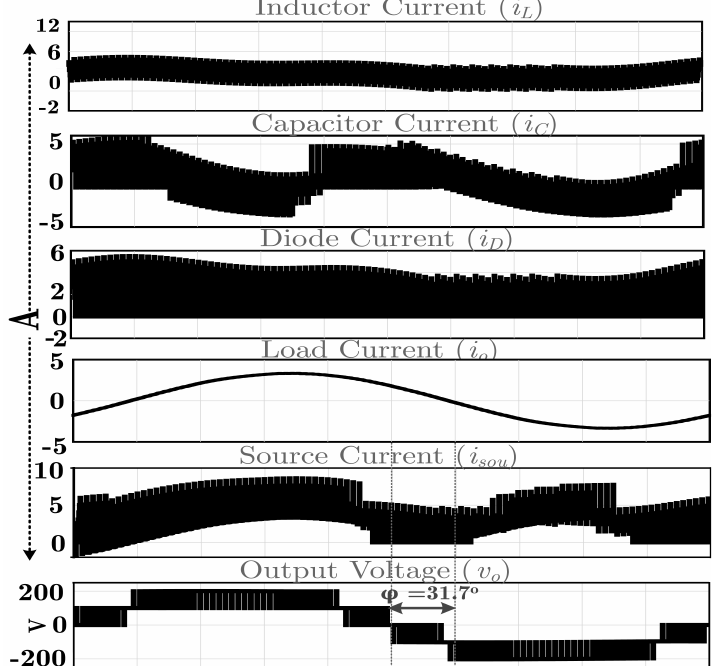
Figure 5. Simulation results for R = 50 Ω and L = 100 mH. The capacitor PG-6DI is used at 150 V/470 µF and a ferrite core type inductor with a value of 2 mH for both simulation and prototype. The SKM75GB63D Semikron IGBTs are used, and the gating signals are driven by TLP 250. The power diode MUR1520G is used. The switching frequency is 20 kHz, and the fundamental frequency is 50 Hz. However, this type of circuit suffers from the pulsated DC source current due to the series connection of the capacitor. The experimental results are shown in Figure 6. In Figure 6, the output voltage and current are measured. Because the 5L-SBI is a boost-type inverter, it is necessary to measure the voltage and current of the inductor, as presented in Figure 6a. It confirms that the inductor voltage is equal to the source voltage.